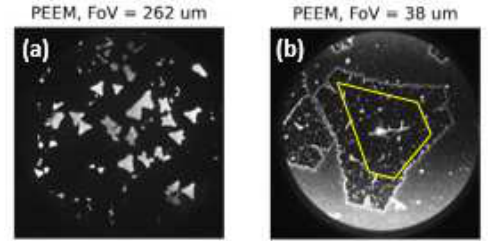
Figure 2 Large field of view (a) and detailed (b) real space PEEM images taken using Hg photon source (~4.9eV). The region of the flake selected by iris for k-PEEM is highlighted by yellow